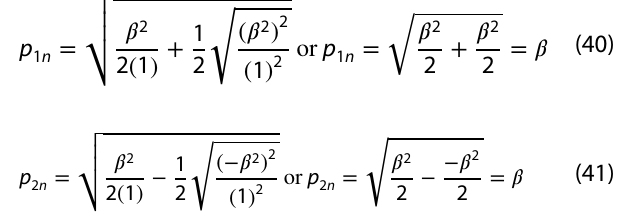
) of the spring-mass k